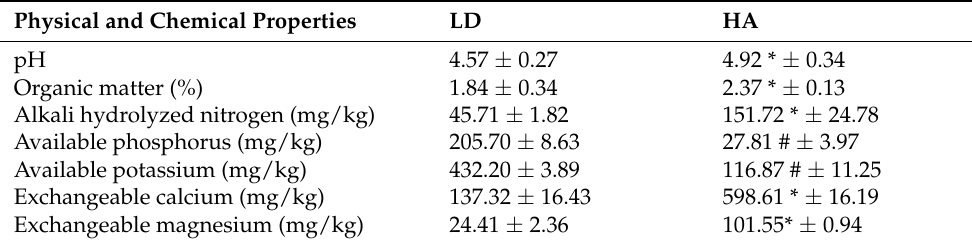
Table 3. Effect of compound humic acid on rhizosphere soil pH, physical and chemical properties of decline diseased